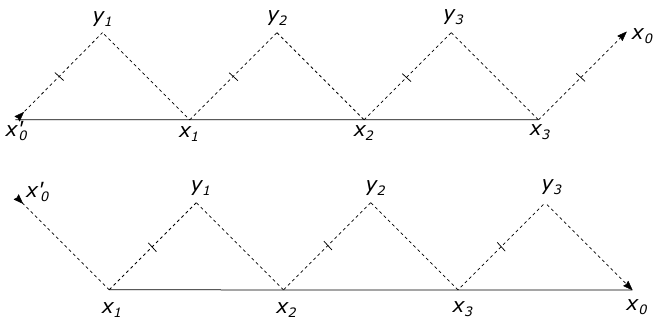
ˆ ˇ Q ν,‘ ( x | y ) (up) and Q ν,‘ ( x | y ) (down) ) 2 ) − 2 iλ , the dashed k − x h